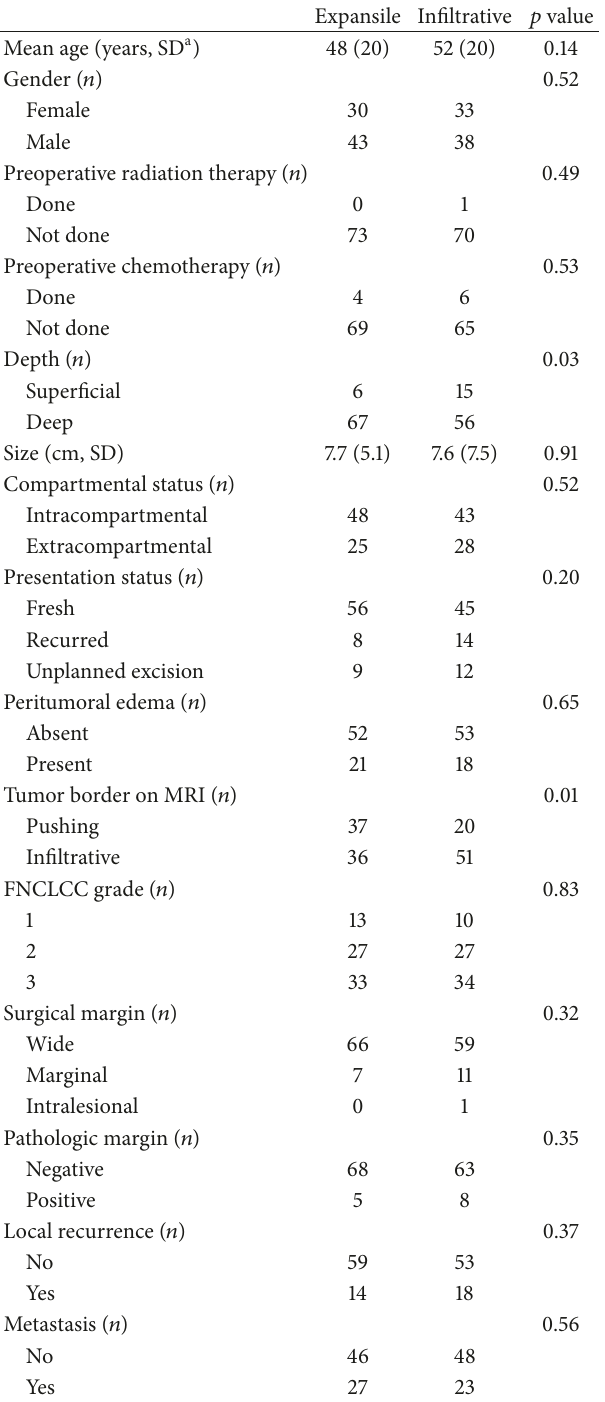
Table 2: Comparison of preoperative characteristics by histological growth